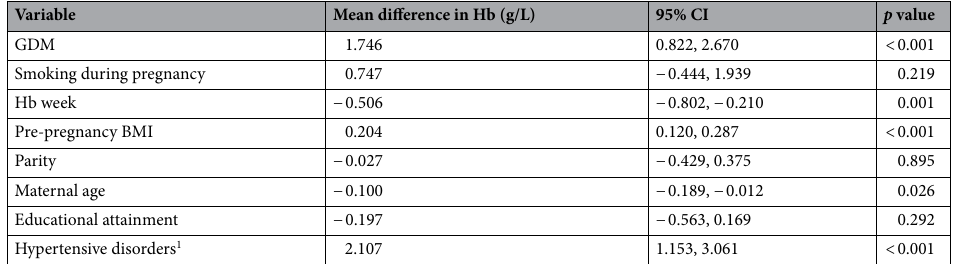
Mean difference in Hb